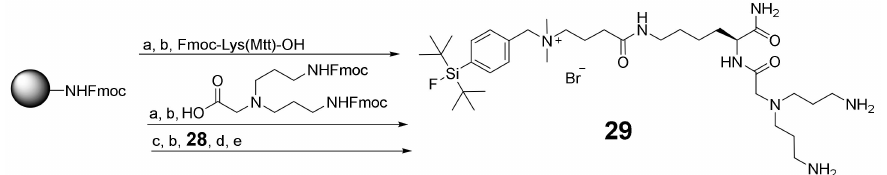
Scheme 4. Schematic depiction of the synthesis pathway towards the SiFA lin -modified branching framework 29 . Conditions: ( a ) deprotection of Fmoc-PG: piperidine/DMF (1/1, v / v ), 2 + 5